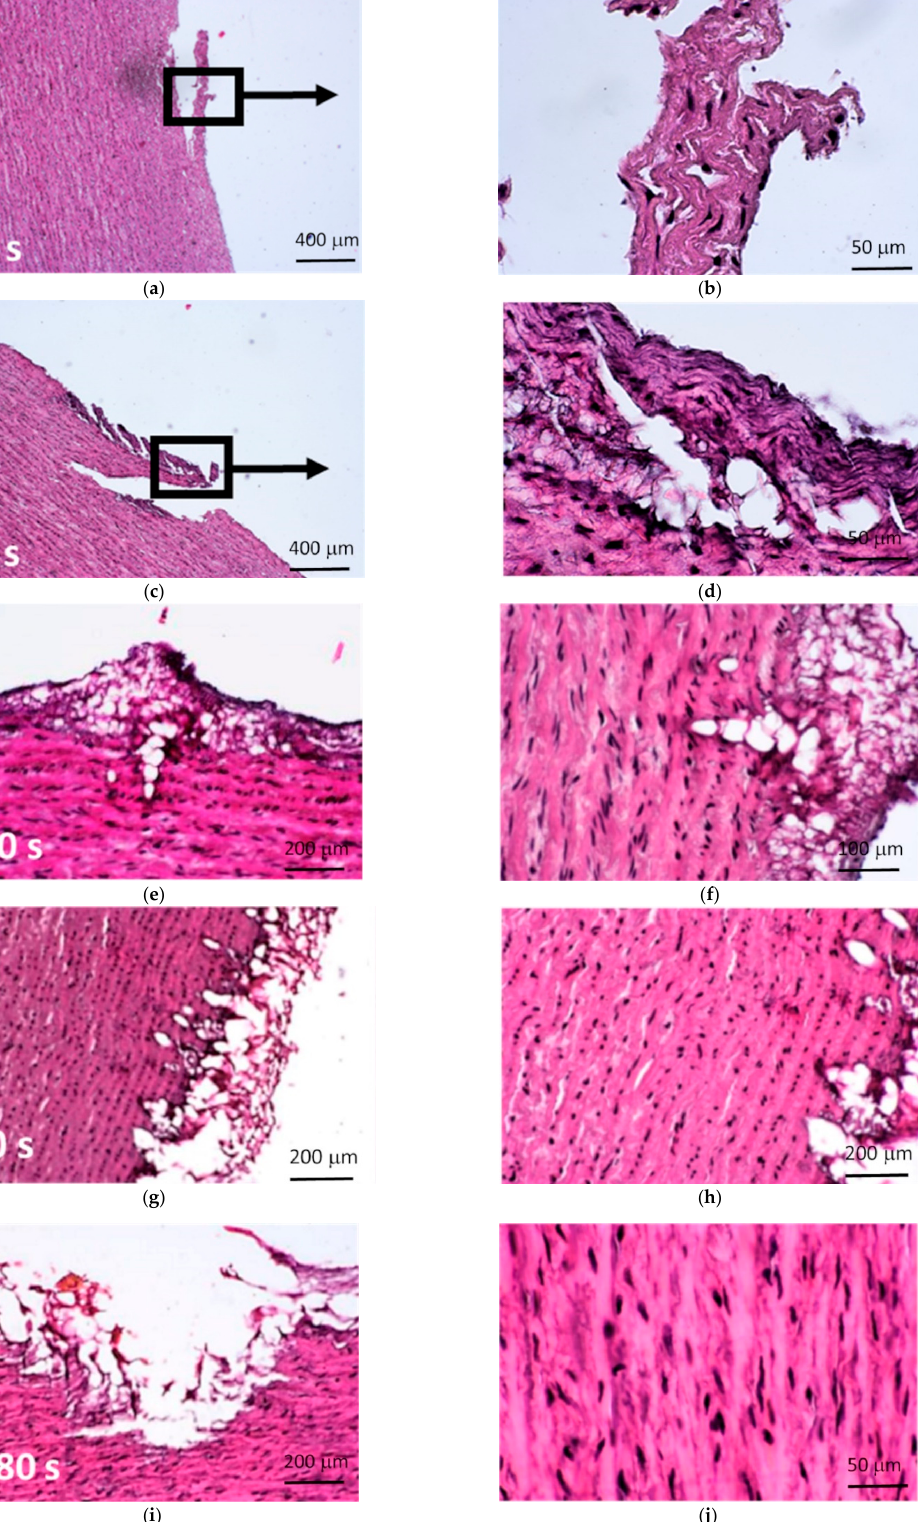
Figure 12. Micrographs of the aortic walls subjected to proton irradiation showing increasing dam- aging effect of ECM with the time of proton irradiation. Exposition times: ( a , b ) 2 s; ( c , d ) 5 s; ( e , f ) 10 s; ( g , h ) 30 s; and ( i , j ) 180 s. Right panel shows higher magnifications of the affected areas (HE stain- ing). Cell nuclei remained visible in all specimens. At the same time, basophilic (hematox- ylin stained) streaks were observed, which were locally present in the samples with shorter exposure times, while in the sample exposed for 180 s they were present over the entire observed area. For all exposure times, tissues subjected to proton irradiation exhibited changed bi- ological structure. In the area of beam–tissue interaction, severe damage and disintegra- tion of the ECM was observed, which increased with the exposition time. The structure of the ECM for the sample with the longest irradiation time (180 s) was completely disrupted and seemed to be “melted”. In the case of 30 s exposition to proton beam, the connective tissue fibers were deformed and merged. In samples irradiated for 2, 5 and 10 s, a normal pattern of the ECM organization was no longer detectable. 4. Discussion The decellularization method based on interaction with a proton beam seems to be a promising physical method that can be effectively used to remove cells from a tissue. Pro- ton radiation is normally used for destroying cancerous cells. The biological effect of pro- ton radiation depends on physical factors, such as the geometrical distribution of the ra- diation dose and biological factors, comprising inter alia, intrinsic radioactivity of cells, oxygenation, position of cells in the life cycle, and degree of hydration [54,55]. Radiation, when penetrating living matter, induces a series of successive processes which vary con- siderably over time. During interaction of the ionizing radiation beam with living matter, the absorption of radiation energy by atoms and particles along the radiation beam takes place within 10 − 18 s. Absorption of the incident energy of the proton beam causes ioniza- tion and excitation phenomena in the targeted tissue. The ionization is more effective as a damaging factor than the excitation because it occurs at energies higher than 10 eV, i.e., corresponding to the protein ionization potential. The ionization probability of the irradi- ated cells depends on the speed and charge of the ionizing particles and is determined by the Linear Energy Transfer (LPE) coefficient [70]. It refers to the amount of energy lost by the ionizing particle after passing a unit distance in the propagation medium. In order to induce cell death, the radiation energy must be deposited at critical sites in the cells nuclei. There are two possible mechanisms of radiation interaction within the biological shield (being a critical element of the cell): direct and indirect. A direct biological effect refers to an interaction of the radiation with the atoms of the DNA molecule, causing defects that disable cell reproductive potential. The indirect effect is characterized by the fact that the cellular component critical to the cell survival interacts with free radicals. Ionizing radia- tion causes radiolytic decomposition of water in cells along with the formation of hydro- gen and hydroxyl free radicals, which indirectly cause damage to the biological shield.